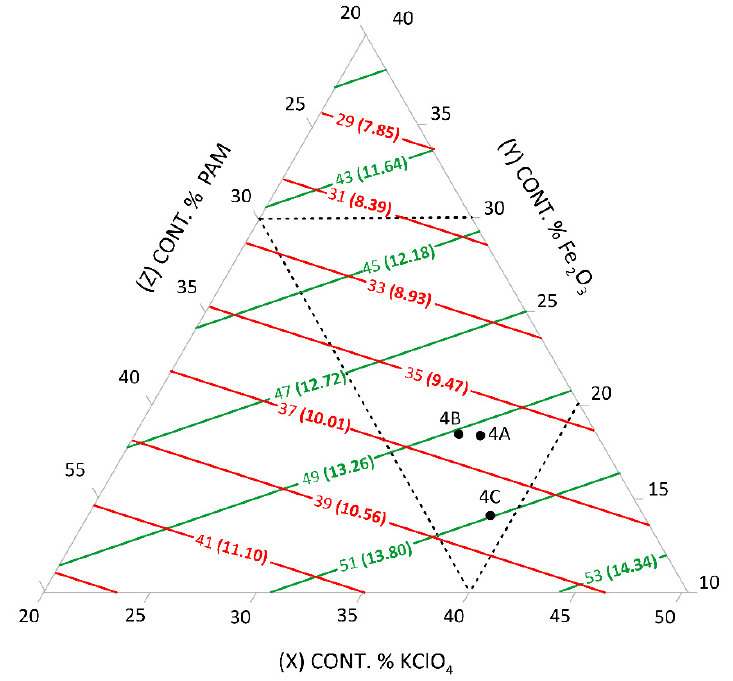
Figure 4. Relationship between costs of the composition (USD/kg): red line—1981, green line—2021; and the content of pyrotechnic composition components (%). Sides of the triangle, with fixed sulphur content S = 20%.